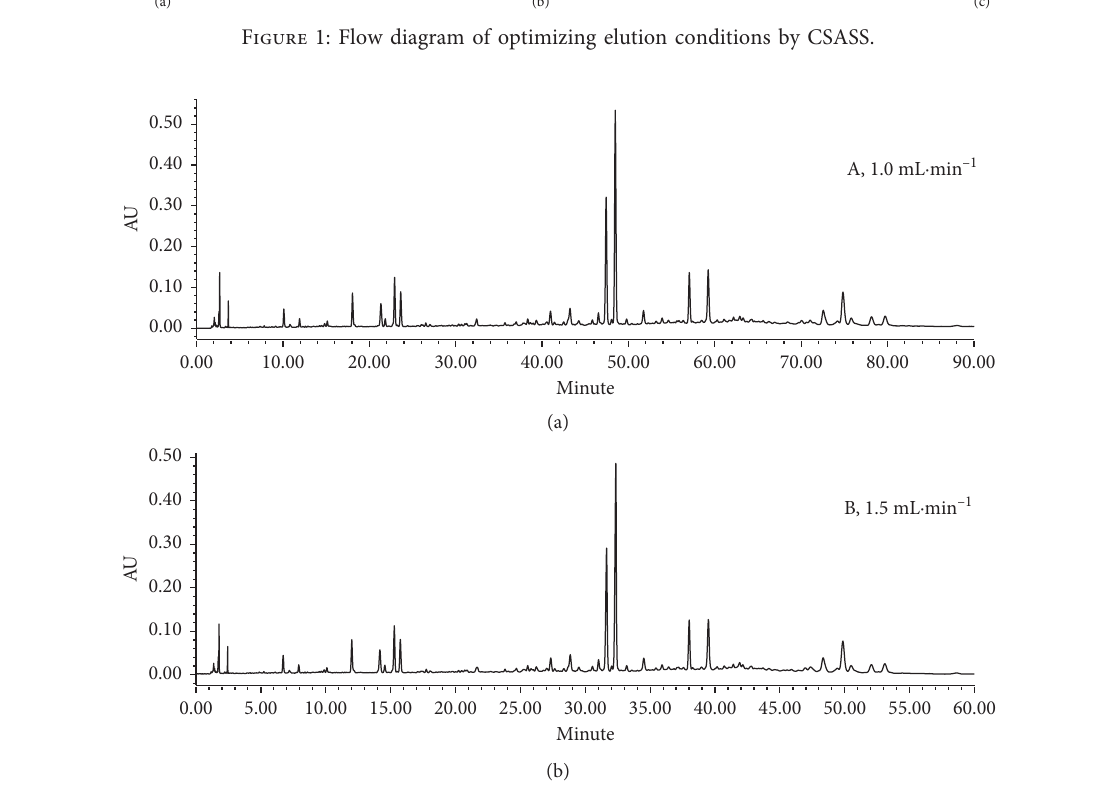
Figure 2: Chromatograms of XJC sample under two conditions. The analysis was performed on Waters Alliance HPLC instrument with the Tnature C18 column. The mobile phase was acetonitrile and 0.1% (v/v) phosphoric acid aqueous solution. The column temperature and flow rate were (a) 30 ° C, 1.0mL • min -1 ; (b) 40 ° C, 1.5mL • min -1 . The detection wavelength was 240nm. The elution gradient was 0–40min, 12%– 98% acetonitrile and 40–55min, 98%-98% acetonitrile.